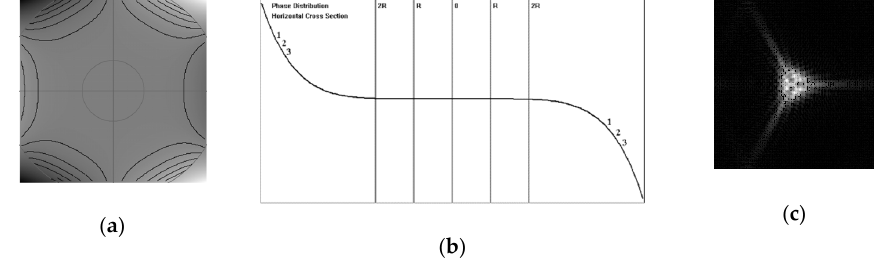
Figure 3. The same as in Figure 2, but the phase was specified by polynomial No. 9 (trefoil). Phase surface ( a ), cross-sections of phase surface ( b ) and corresponding amplitude distribution ( c ) are shown. Three cross-sections coincide ( b ).